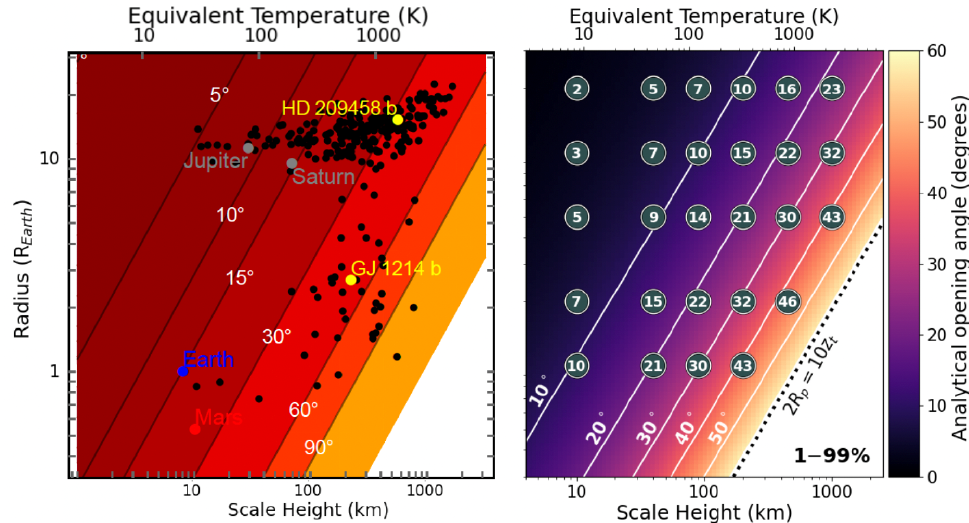
Figure 7. Opening angles according to the atmospheric scale height and the radius of the planet. ( Left ) Simple estimate of the opening angle of the region around the terminator that affects the transmission spectrum (i.e., the limb) [68]. The atmosphere is assumed to become transparent above the 1 Pa pressure level. Black dots are known planets for which the radius and surface gravity have been measured. ( Right ) Analytical calculation of the opening angle [17]. The values in the gray circles denote the opening angles (in degrees) that were geometrically calculated from the Monte-Carlo radiative transfer [17]. Despite the differences in these two plots, in particular for the large-scale height and radius, the trends are similar. For warm Neptunes, such as GJ1214b, or hot Jupiters, such as HD209458b, the opening angles are large (25 ◦ to 35 ◦ , respectively) and denote that the probe region extends significantly above the terminator of the